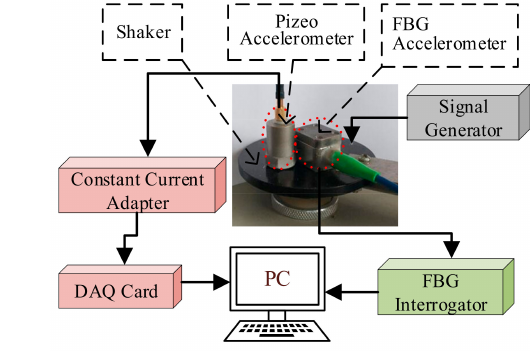
Figure 2. Experimental setup.